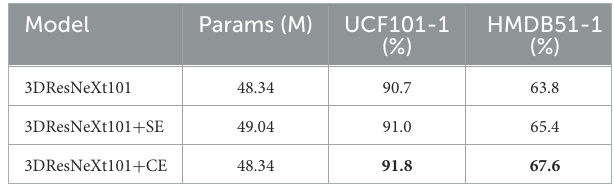
TABLE 3 The effect of the CE module.